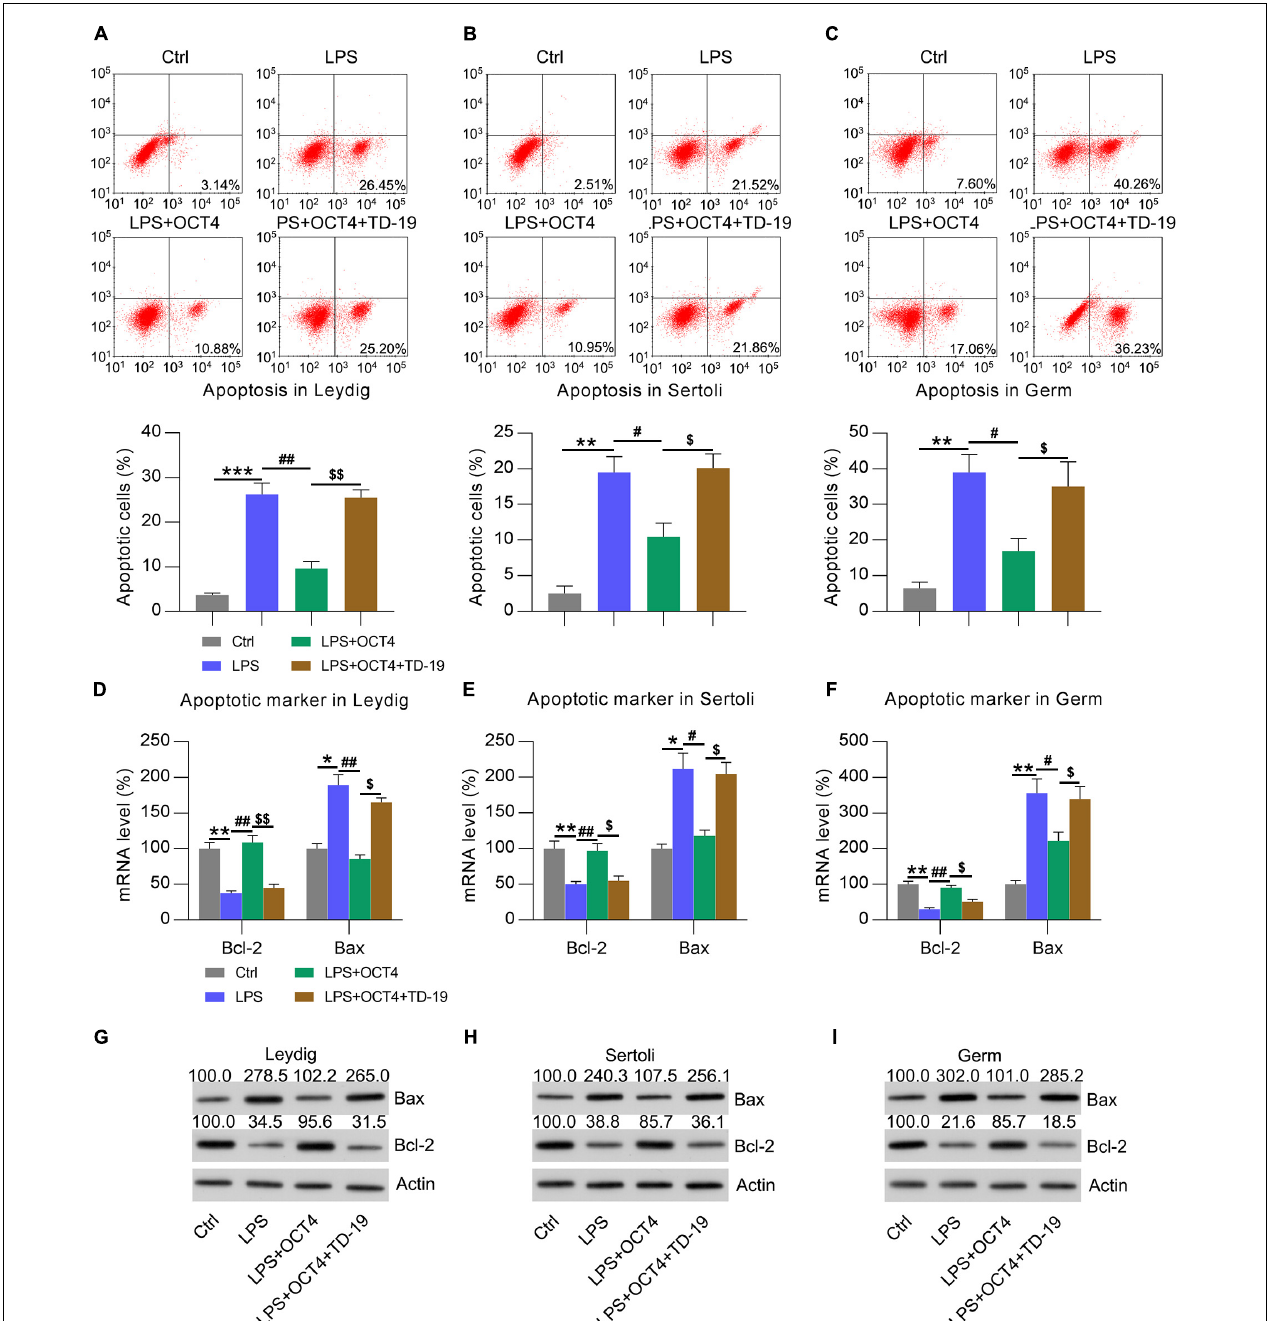
FIGURE 7 | Effects of OCT4 and CIP2A on apoptosis of LPS-induced Sertoli, Leydig, and germ cells. Leydig, Sertoli, and germ cells were transfected with pcDNA3-OCT4 or pcDNA3-NC and then incubated with LPS and TD-19 for 12 h. (A–C) The apoptotic cell count was evaluated using Annexin V-FITC/PI flow cytometry and is displayed in the right quadrant in each plot. The apoptotic rates of each cell type are presented in the lower panel. (D–F) RT-qPCR detection of the mRNA levels and (G–I) WB analysis of the protein expression of Bcl-2 and Bax in the cells. Data are expressed as the means ± SDs. * P < 0.05, ** P < 0.01, *** P < 0.001, Ctrl vs. LPS; # P < 0.05, ## P < 0.01, LPS vs. LPS + OCT4; $ P < 0.05, $$ P < 0.01, LPS + OCT4 vs. LPS + OCT4 +